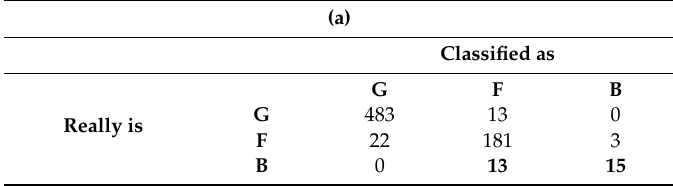
Table 6. Confusion matrix for ( a ) the Tr-Util1 , Ts-Util1 scenario using the kNN classifier, ( b ) Tr-Util1 and Util2 , Ts-Util1 and Util2 scenario using the